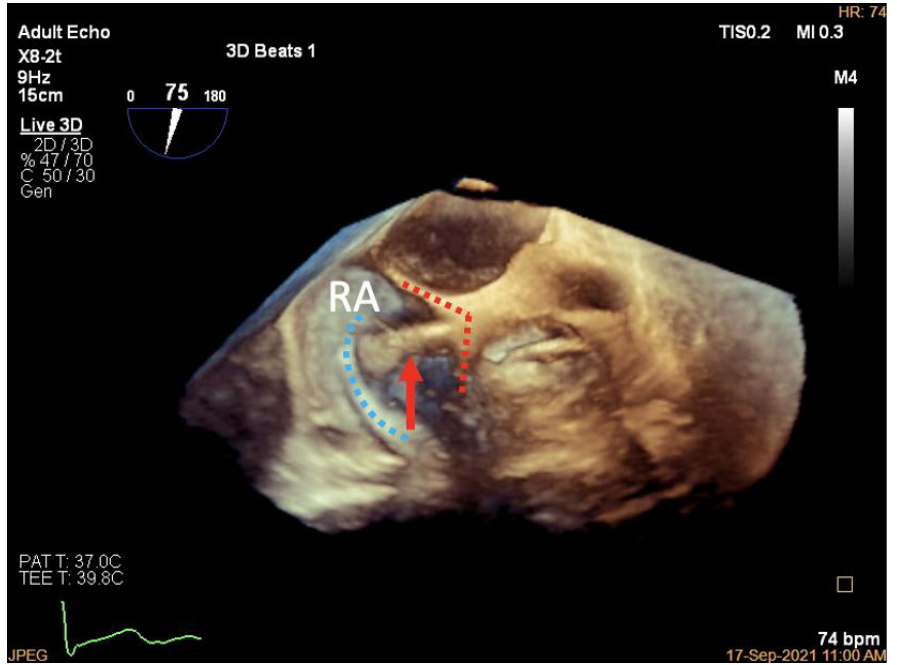
Figure 7. Three-dimensional work plane of K-Clip™ implantation. Three-dimensional work plane confirming tapping screw (red arrow) anchored at the target TA location (posterior TA shown in blue dotted line, clip arms shown in red dotted line). RA, right atrium .